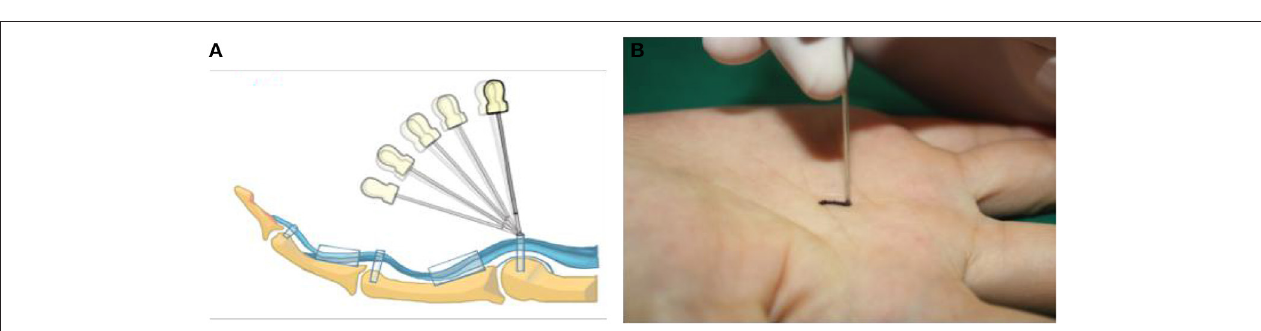
FIGURE 4 | The scheme (A) and spot (B) of the blind release.